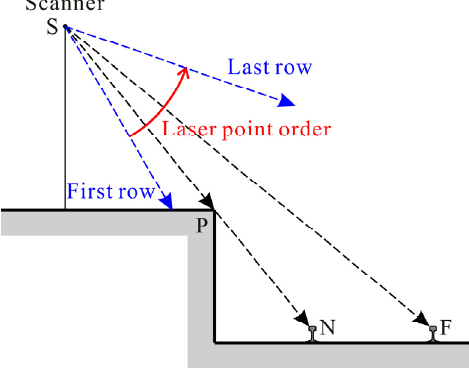
Figure 13. Order of laser points of a primary scan line